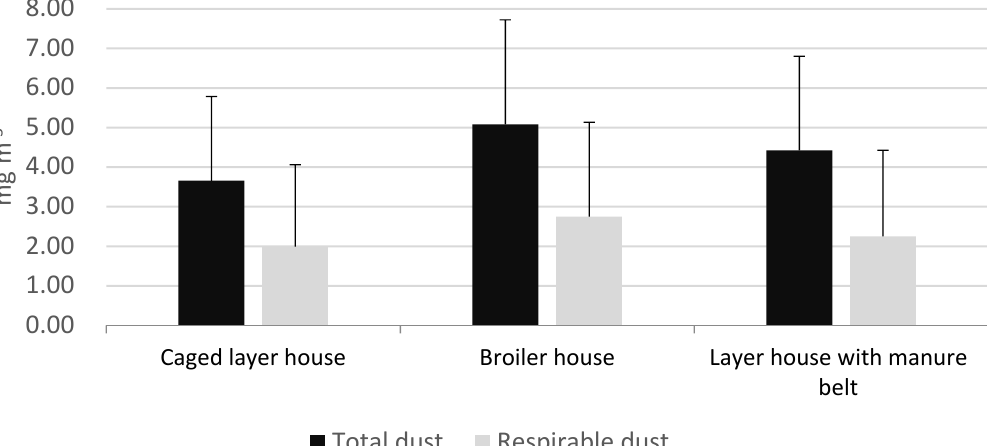
Figure 1. Mean concentrations of total and respirable dust, according to type of poultry house (the error bar represents the geometric standard deviation of the measurement data).